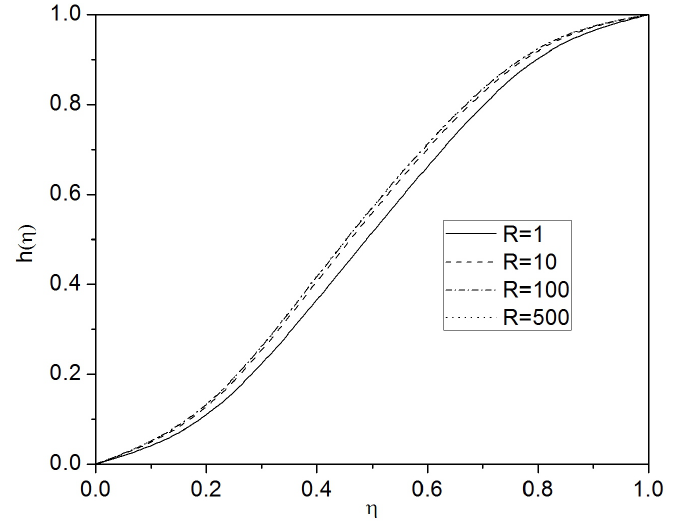
Fig. 3 Variations of h by increasing Reynolds number R